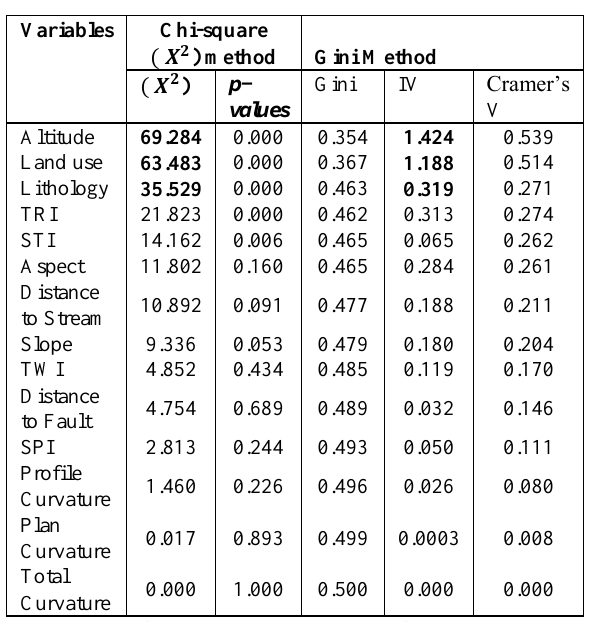
Table 2. The factors importance based on factor optimization (Chi-square and